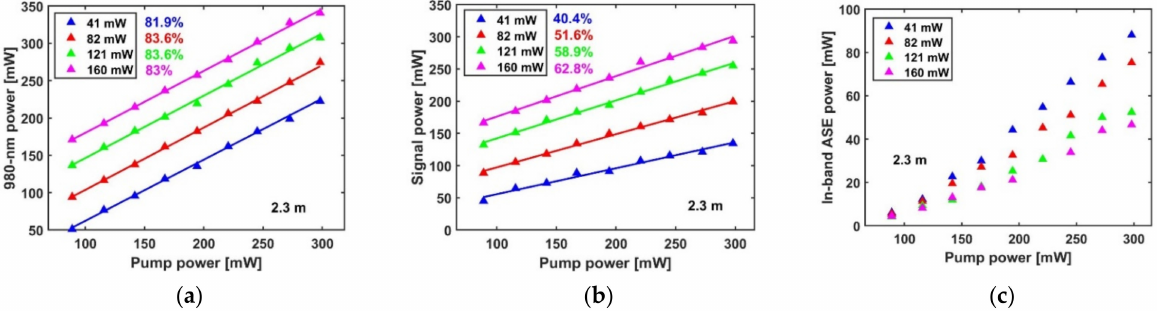
Figure 4. Output power of ( a ) emission around 980 nm and ( b ) signal light and ( c ) in-band ASE